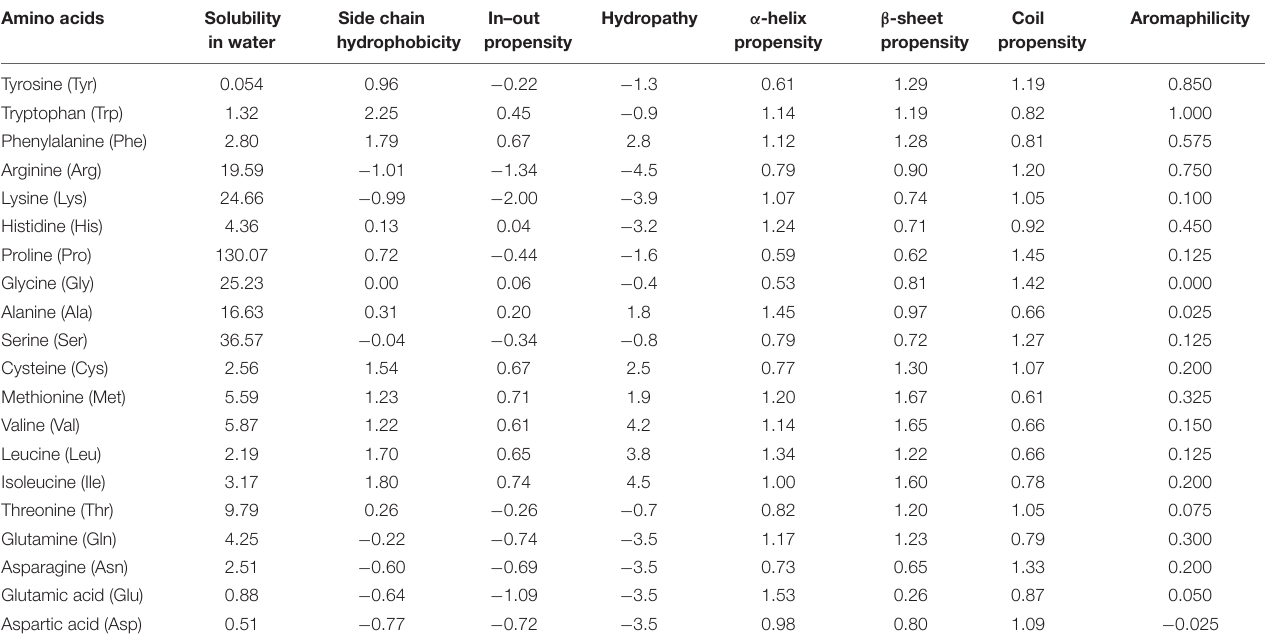
TABLE 1 | Various parameters of amino acid in previous studies. Amino